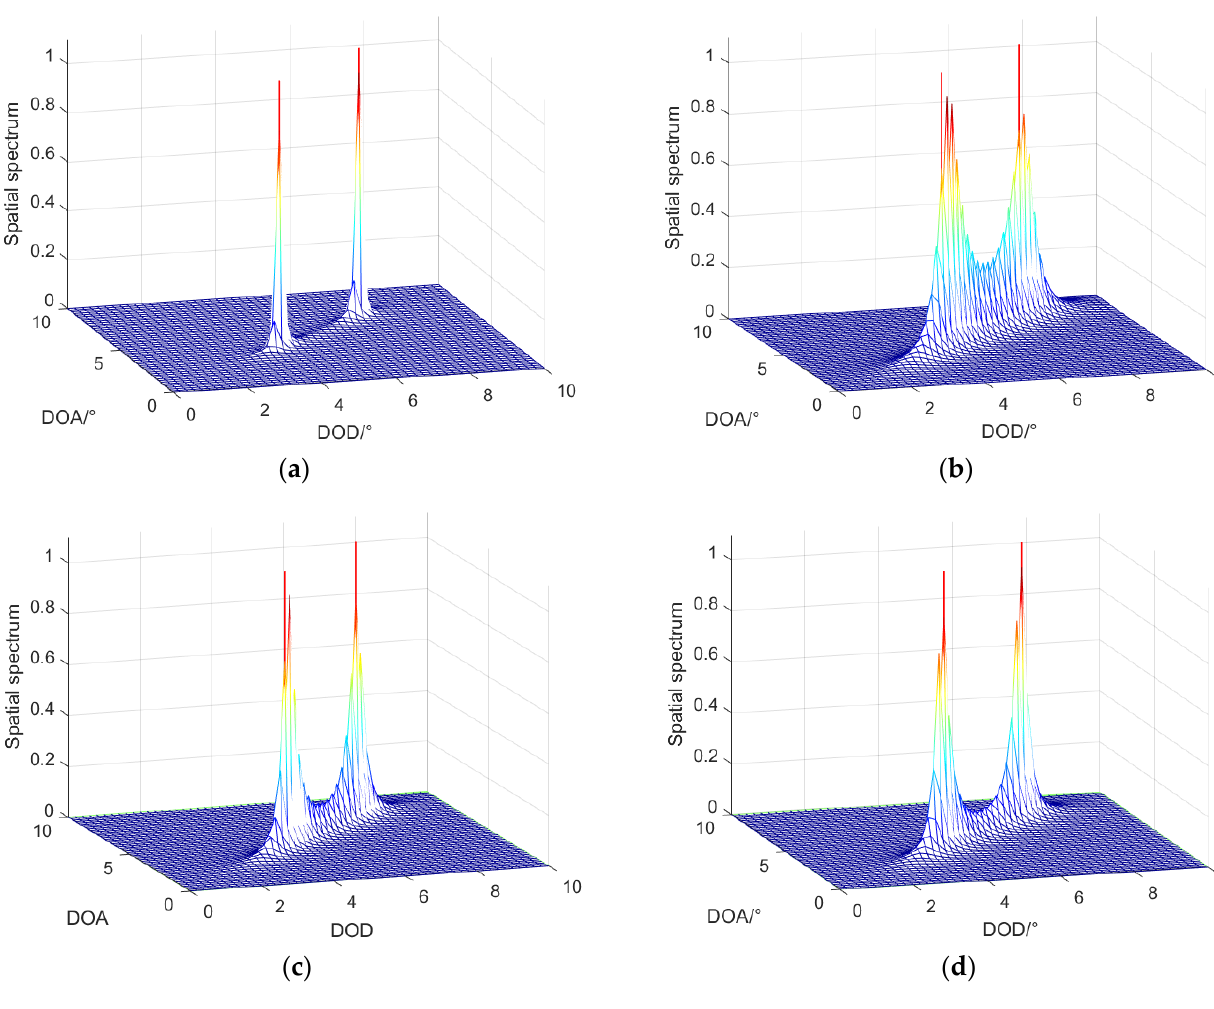
Figure 5. Results of the angular resolution of different algorithms: ( a ) LMR algorithm; ( b ) SMS algorithm; ( c ) ASDS algorithm; ( d ) TRDS algorithm.